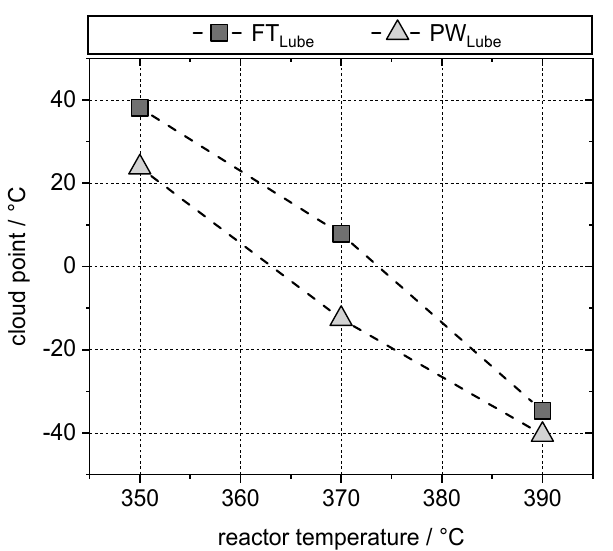
Figure 8. Flow diagram of product yield for catalytic treatment of agricultural films for conditions of HP 370 °C.